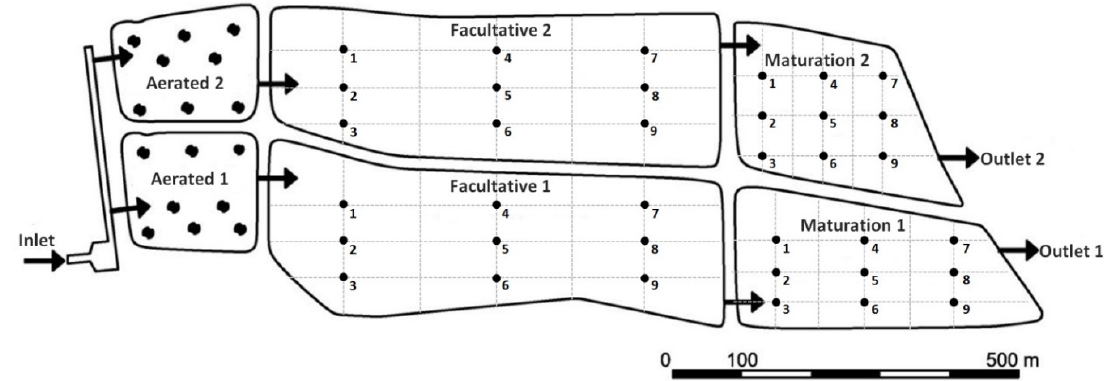
Figure 1. Layout of the waste stabilisation pond and the sampling locations. The arrows represent the location of the inlets and the outlets of the ponds. location of the inlets and the outlets of the